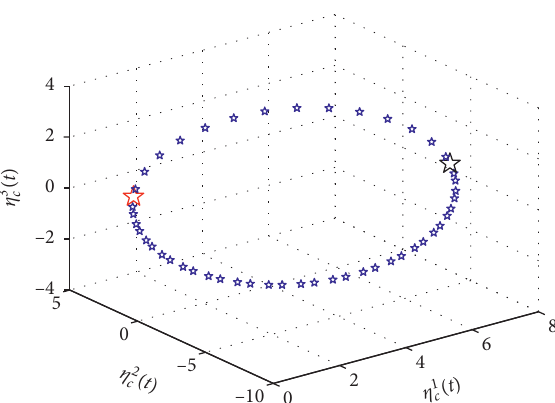
Figure 4: Movement track of the formation center function.